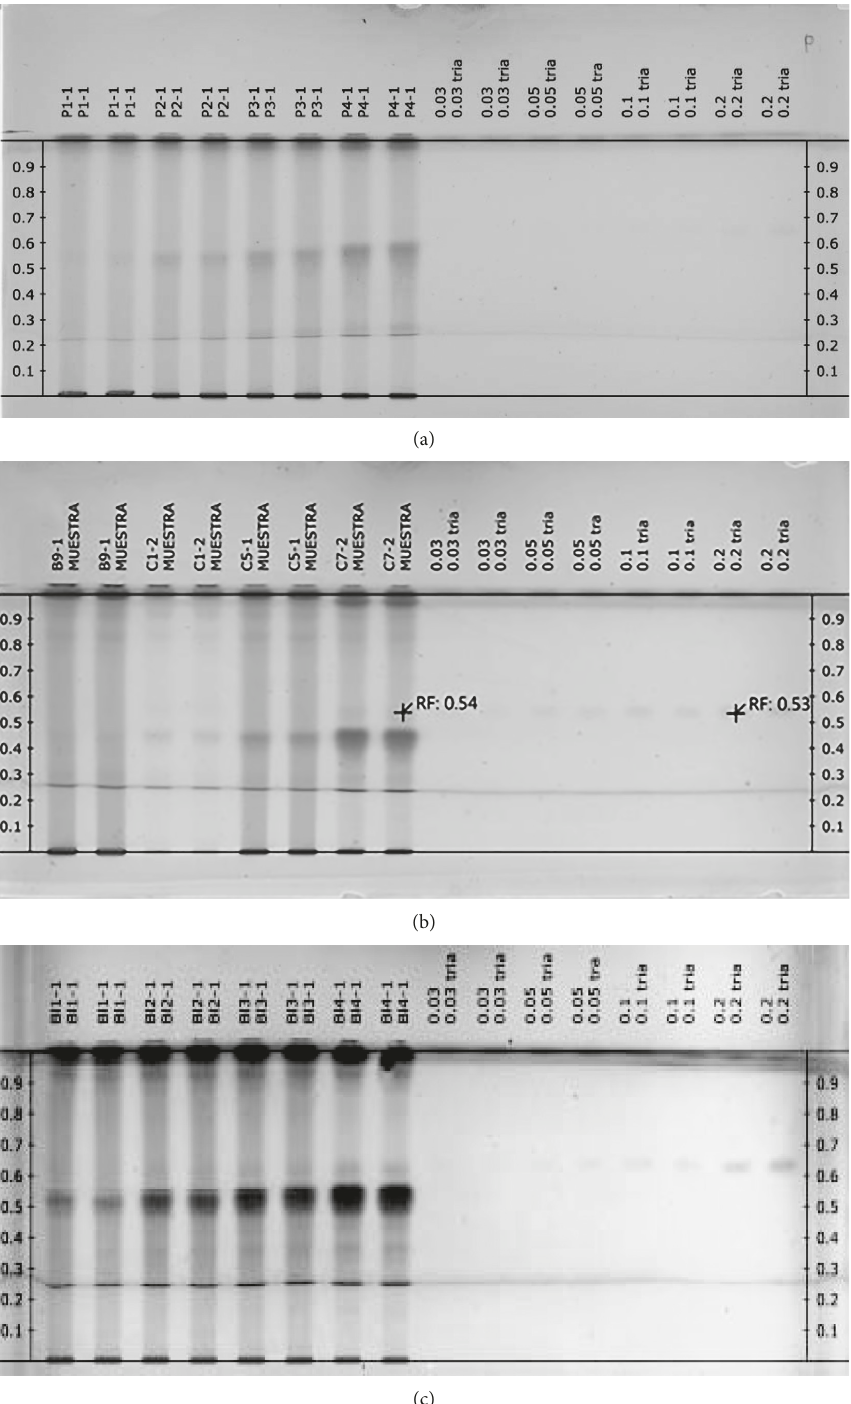
Figure 5: HPTLC chromatoplates. Products of the reaction with (a) propanol, (b) isopropanol, and (c) butanol as acyl receptors and toluene as a reaction medium under orbital